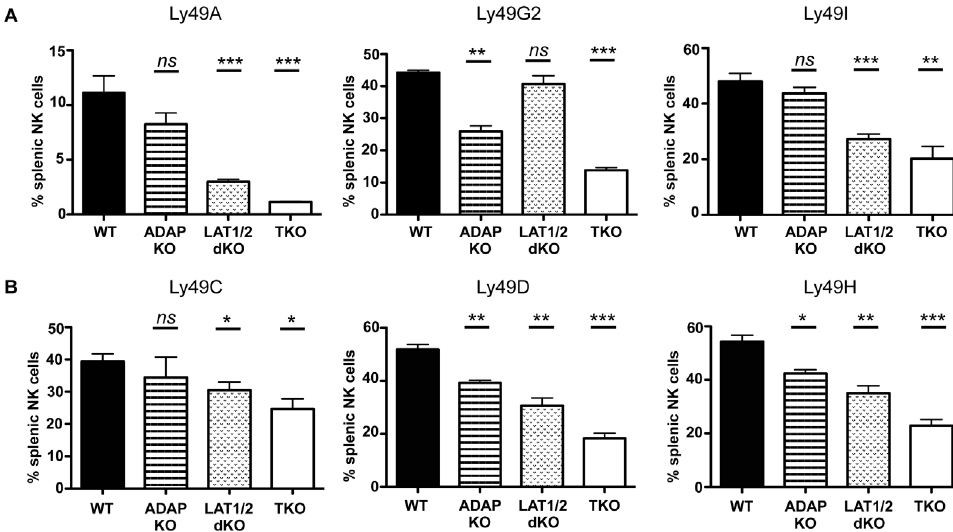
Fig 4. Upstream signaling pathways of SLP-76 differentially contribute to induction of Ly49 expression by NK cells. (A) Splenic NK cells from WT, ADAP KO, LAT1/LAT2 DKO, and ADAP/LAT1/LAT2 TKO NK cells were assessed for expression of NK cell-intrinsic Ly49A, Ly49G2, Ly49I and (B) NK cell-extrinsic Ly49C, Ly49D, and Ly49H. Data are represented as mean percent positive ± SEM of n = 3 – 4 mice per genotype. * p <